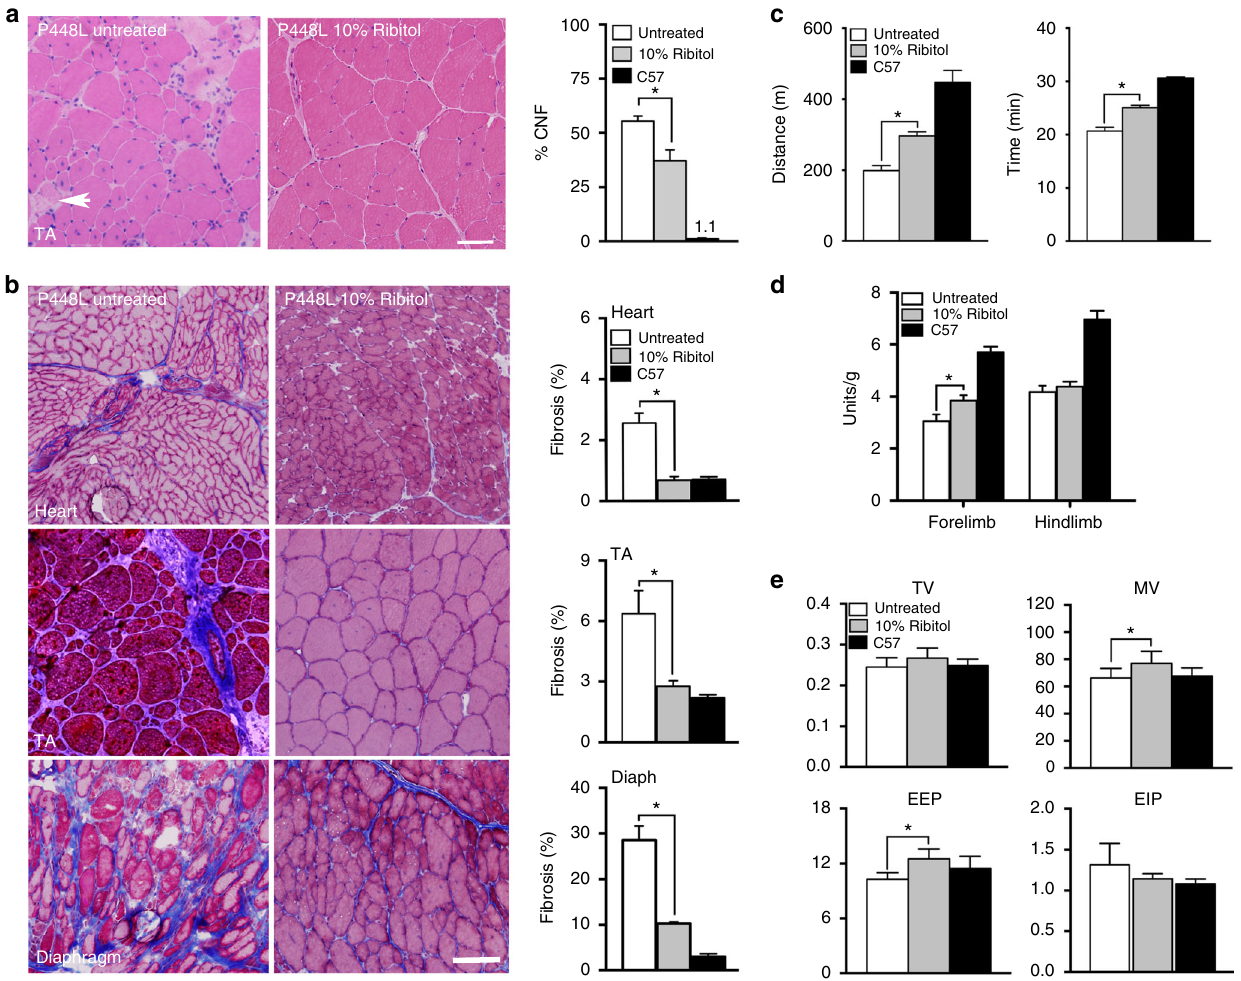
Fig. 7 Effect of 10% ribitol treatment from pregnancy on histopathology and muscle function of P448L mice. Mice were treated from pregnancy to 19 weeks of age. Control P448L mice were given drinking water only. a H&E staining of tibialis anterior (TA) tissues from either untreated or 10% ribitol-treated P448L mice. Arrow indicates the degenerating fi bers. Scale bar, 50 μ m. Percentage of centrally nucleated fi bers (% CNF) in TA muscles treated with 10% ribitol or aged-matched untreated P448L and C57 mice ( n = 3 for all cohorts). b Masson ’ s Trichrome staining of heart, TA (tibialis anterior), and diaphragm. Blue represents area of fi brosis. Percentage of fi brotic areas quanti fi ed from the treated and age-matched untreated P448L and C57 ( n = 3 for all cohorts) mice. c Treadmill exhaustion test assessing distance (m) and running time (min) in untreated ( n = 10) or 10% ribitol-treated ( n = 15) P448L mutant and C57 mice ( n = 10) at the age of 17 weeks. Unpaired t test, * p ≤ 0.05. d Grip strength test in untreated ( n = 10) or 10% ribitol-treated ( n = 15) P448L and C57 mice ( n = 10) at the age of 18 weeks. Force (Units) is normalized to body weight (g). e Respiratory function from untreated ( n = 10) or 10% ribitol-treated ( n = 15) P448L and C57 control mice ( n = 10) at 18 weeks of age (TV tidal volume, MV minute volume, EEP end-expiratory pause, EIP